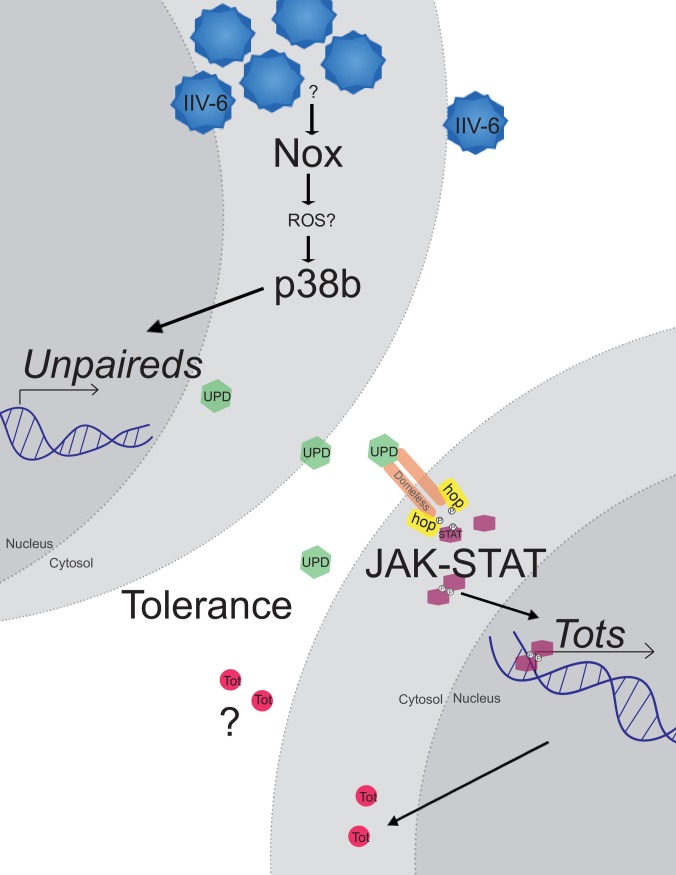
IIV-6 infection activates a protective response through p38b and JAK-STAT signaling IIV-6 infection activates p38b through the NADPH oxidase Nox and presumably ROS production. p38b triggers the induction of the unpaireds, which encode for secreted ligands which activate the JAK-STAT pathway via the receptor, Domeless. JAK-STAT signaling leads to induction of the Turandots (Tots), a family of small, secreted proteins with no known function. JAK-STAT as well as p38b signaling protects Drosophila from IIV-6 infection, and p38b in particular increases tolerance to this virus.